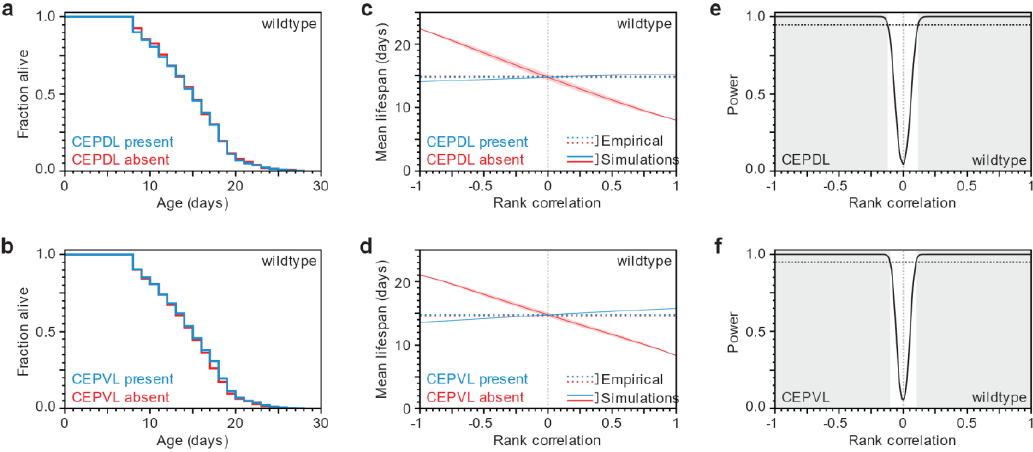
Figure 2. Independence of neuronal loss and organismic death in wild-type animals. ( a , b ) No difference in lifespan was observed when 3397 seven-day old wild-type animals expressing α-synuclein in the dopaminergic neurons were grouped according to whether the specified cephalic neuron was present (blue line) or absent (red line). For statistics see Table S2, Supplementary Materials; ( c , d ) Using computer simulations (Figure 3), we predicted how the mean lifespans of seven-day old animals with present (blue line) and absent (red line) cephalic neurons are influenced by the Spearman’s rank correlation between the timing of neuronal loss and lifespan. The shaded areas represent the 95% point-wise confidence interval of the predicted mean lifespans. The observed mean lifespans (dotted lines) are only consistent with correlations of low magnitude; ( e , f ) The statistical power of our experiment is the fraction of simulations with a significant ( p < 0.05) difference in survival between the neuron present and absent groups. The shaded region denotes the Spearman’s rank correlation values where statistical power is greater than 95% (dotted line). For the analysis based on the state of CEPDR and CEPVR on day 7, see Figure S3, Supplementary Materials.